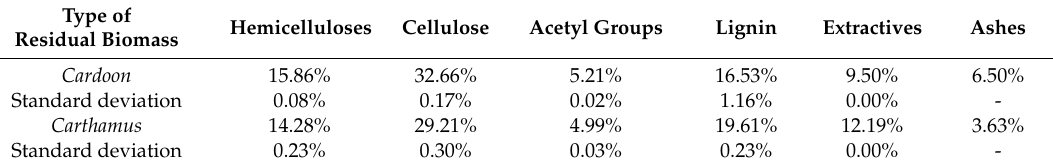
Table 3. Components of the lignocellulosic residual biomass measured by the CRB/CIRIAF